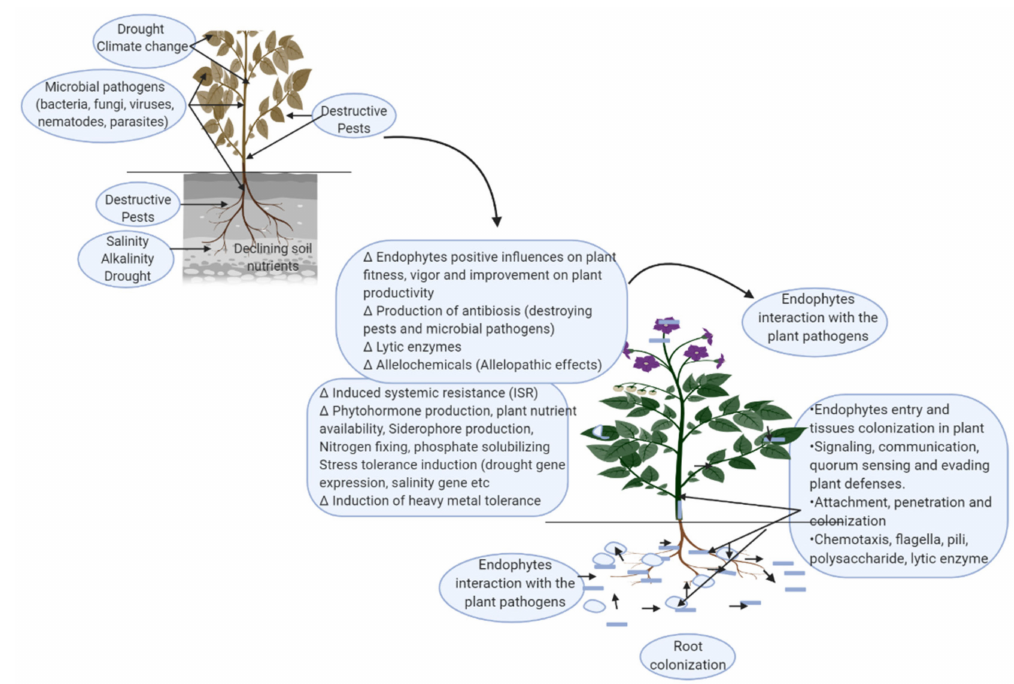
Figure 1. Diagrammatic representation of the functional traits of endophytic bacteria and fungi that are of benefit to